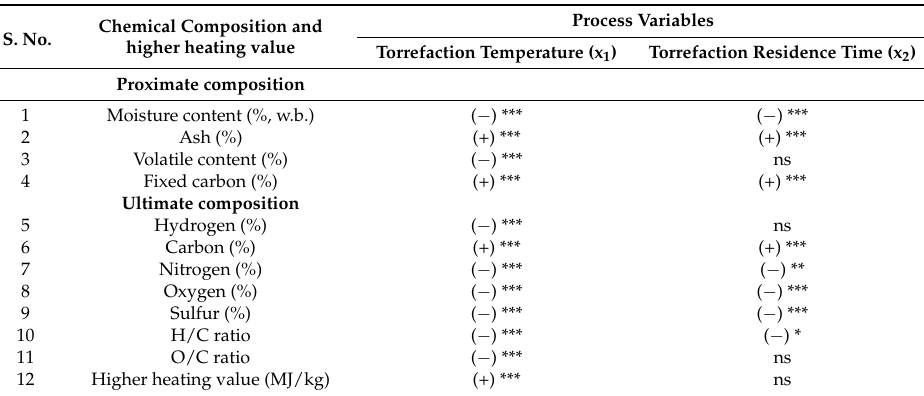
Table 5. Analysis of variance for the chemical and energy